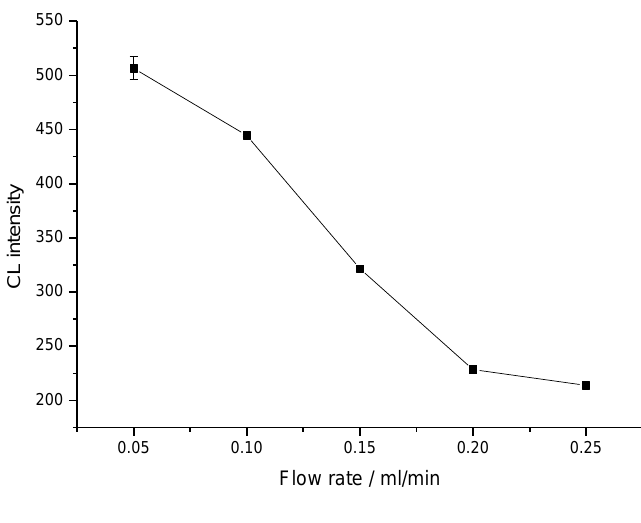
Figure 3. Effect of flow rate of pre-incubation immunomixture through the immunoaffinity column on the CL intensity. Pre-incubation time of 0 ng/mL CEA with enzyme tracer was 25 min